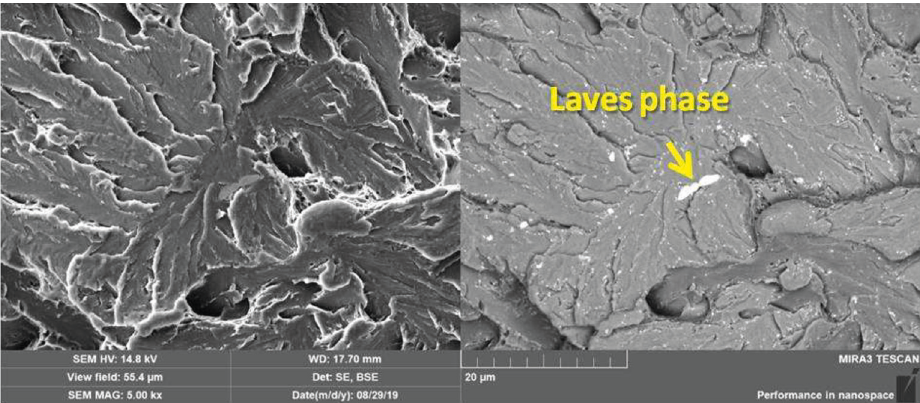
Figure 8: The impact fracture morphologies of G115 steel aged at 650 ° C for 500h.